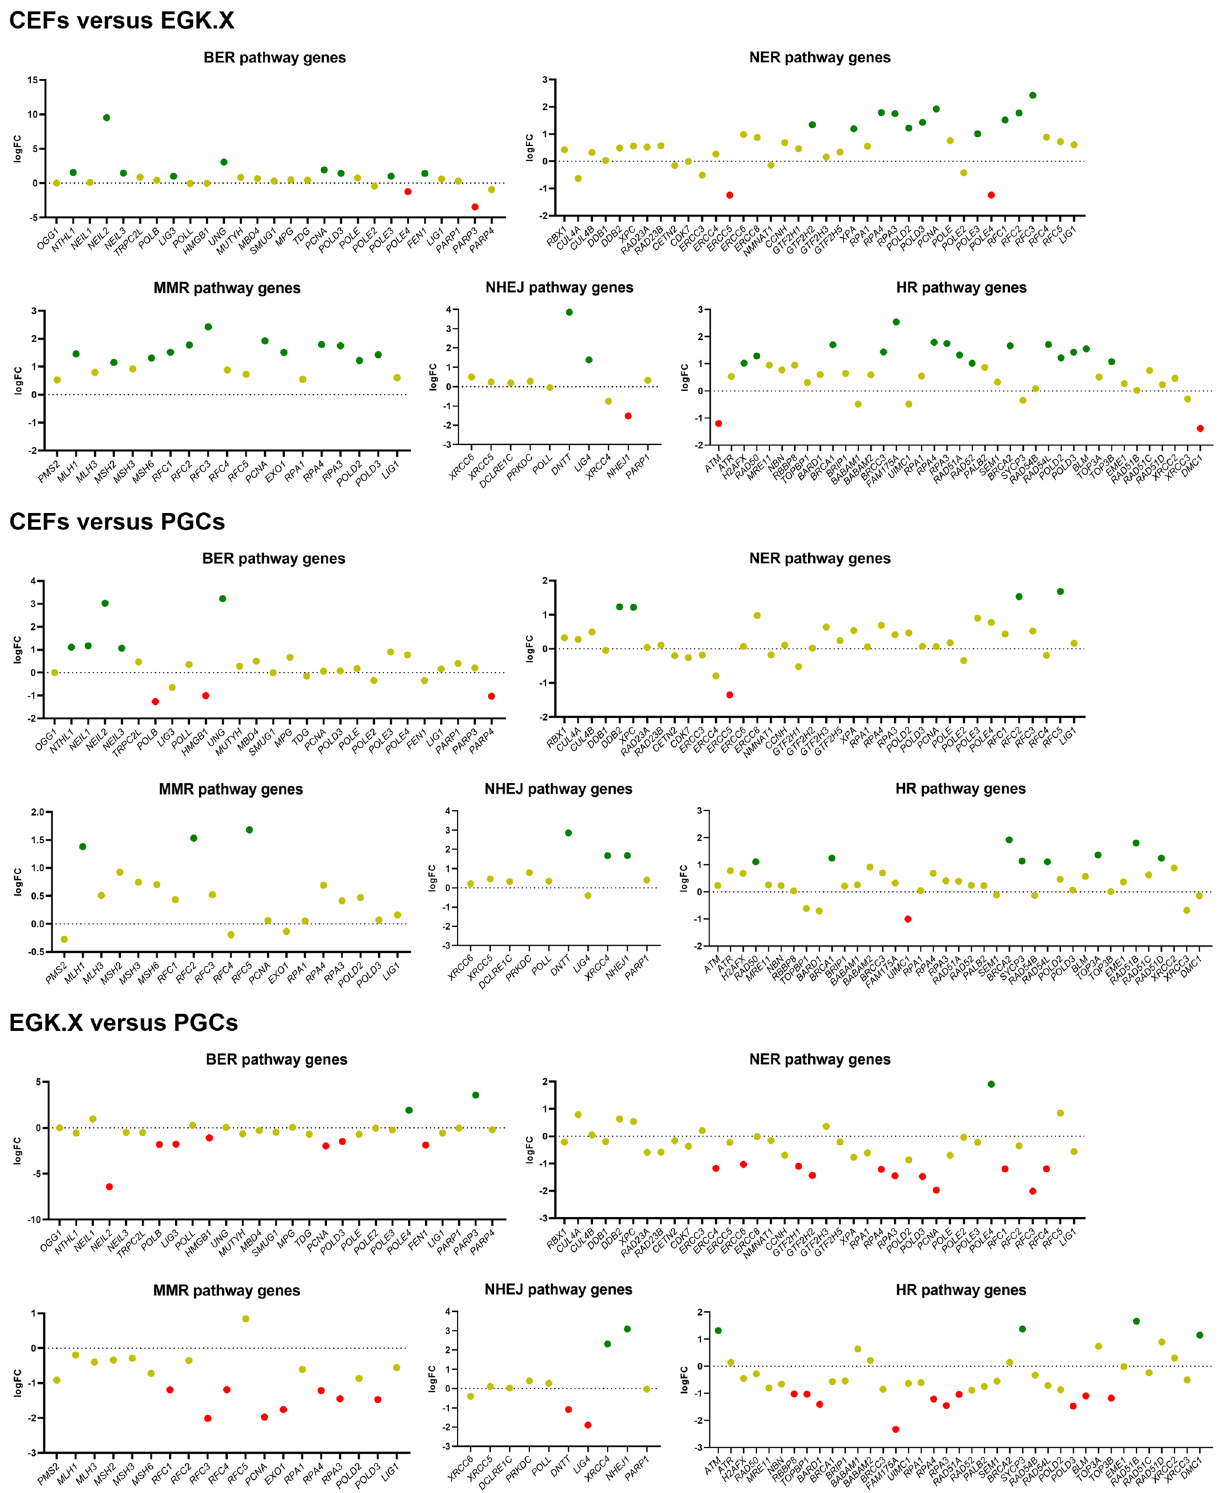
Figure 3. Differentially expressed genes (DEGs) of the DNA repair pathway between the test samples. DEGs in EGK.X blastoderms compared with CEFs, DEGs in PGCs compared with CEFs, and DEGs in PGCs compared with EGK.X blastoderms were shown in the top, middle, and bottom graphs, respectively. Green: significantly upregulated. Red: significantly downregulated. Yellow: